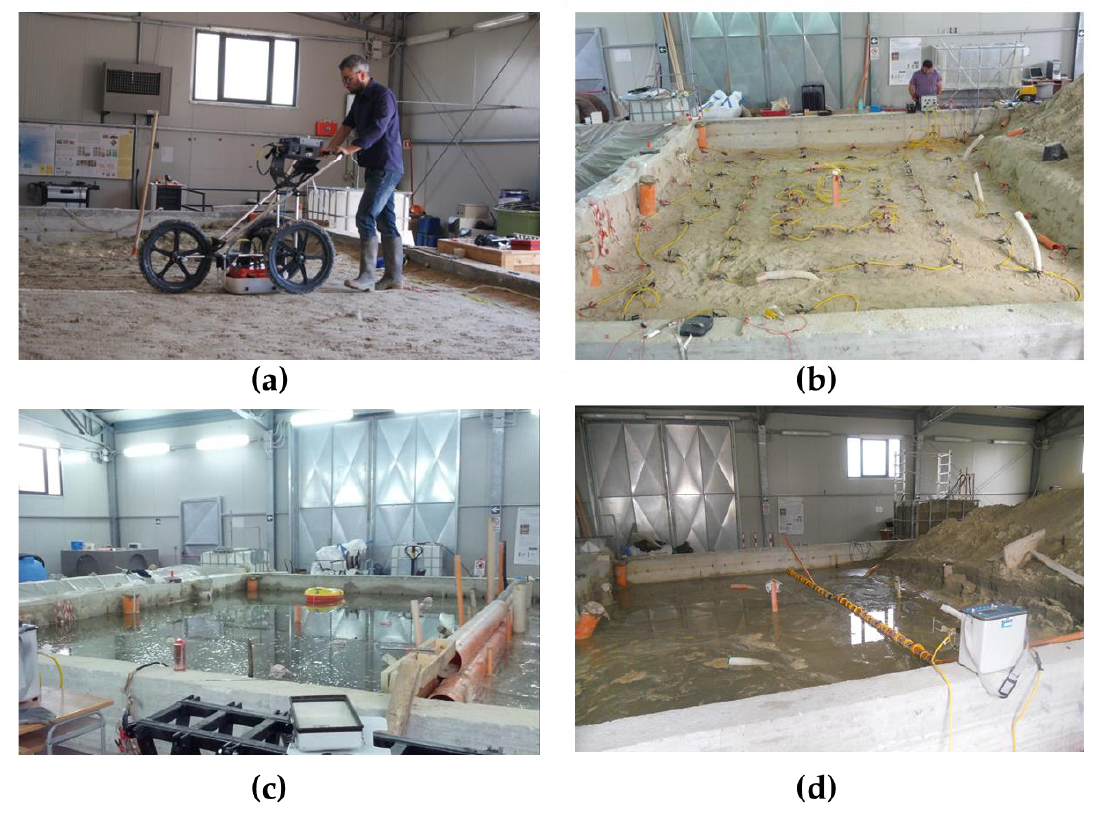
Figure 4. GPR Sir 3000 and 400 Mhz antenna with survey wheel: ( a ) loop–loop ERT acquisition system ( b ) performed in WP1 (unsaturated scenarios), 400 Mhz GPR antenna on a small boat, and ( c ) a 2D ERT profile with floating electrode ( d ) in WP2 (underwater scenario).